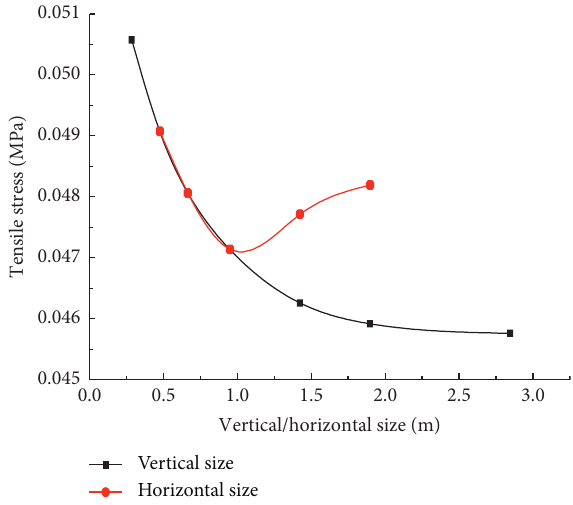
Figure 21: The effect of horizontal/vertical size on tensile stress of joint filling